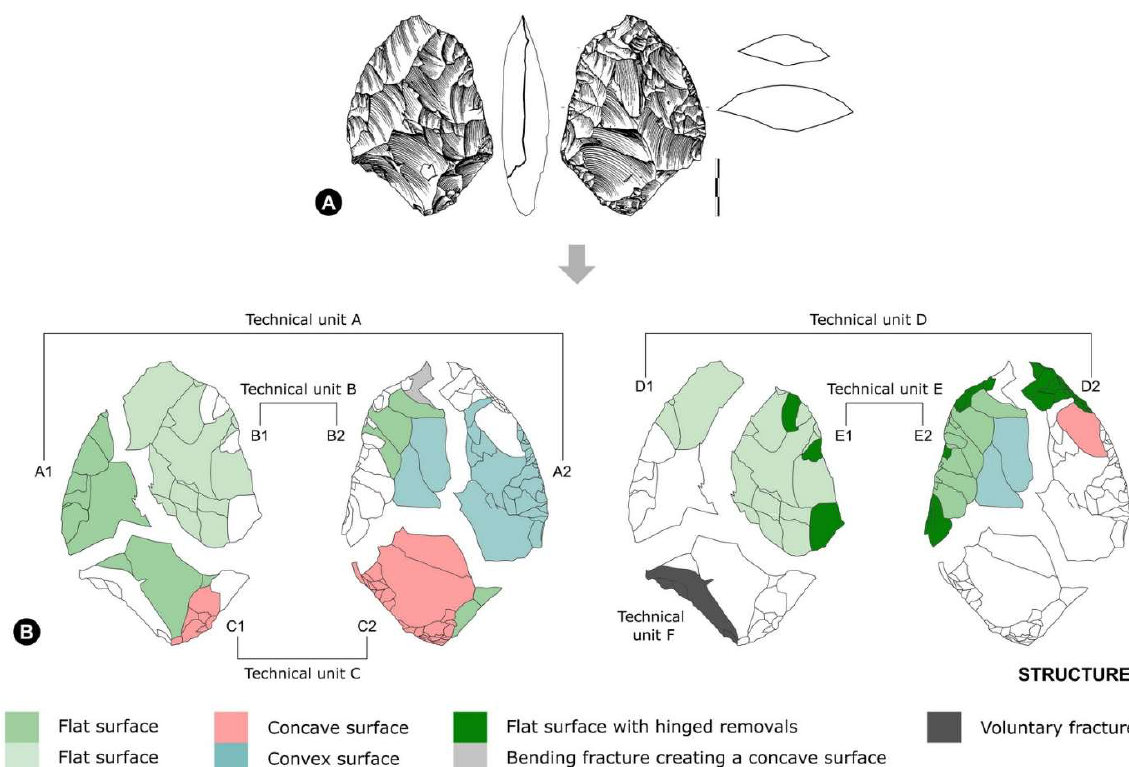
Figure 9. Example of technicofunctional analysis of a bifacial piece from the C'3 base layer of the Barbas I site, Dordogne (Boëda 2001: 63, figs 8 and 9): (A) drawing of the bifacial piece, (B) determination of the technicofunctional units that define the tripartite structure of the bifacial part. Ultimately, at the interpretative level, this structural determination will allow us to define the evolutionary stage (abstract or concrete) to which the piece